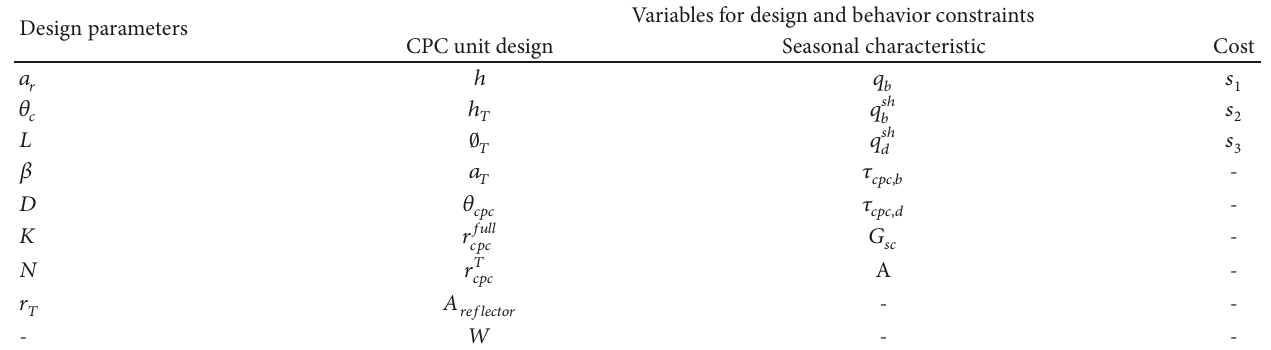
Table 1: Design parameters and variables for design and behavior